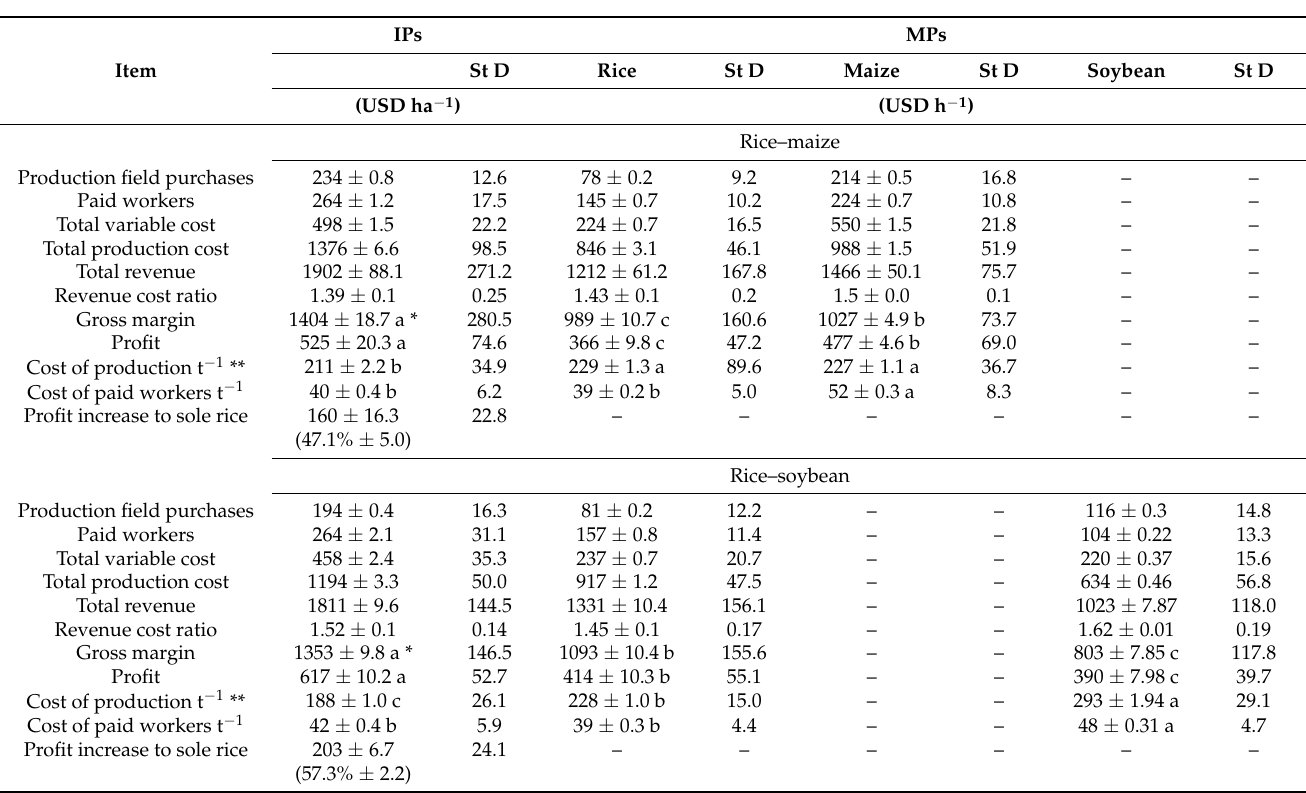
Table 7. Profit analysis of the rice–maize, rice–soybean, and maize–soybean IPs in comparison with MPs in rainfed areas of western Indonesia with a wet